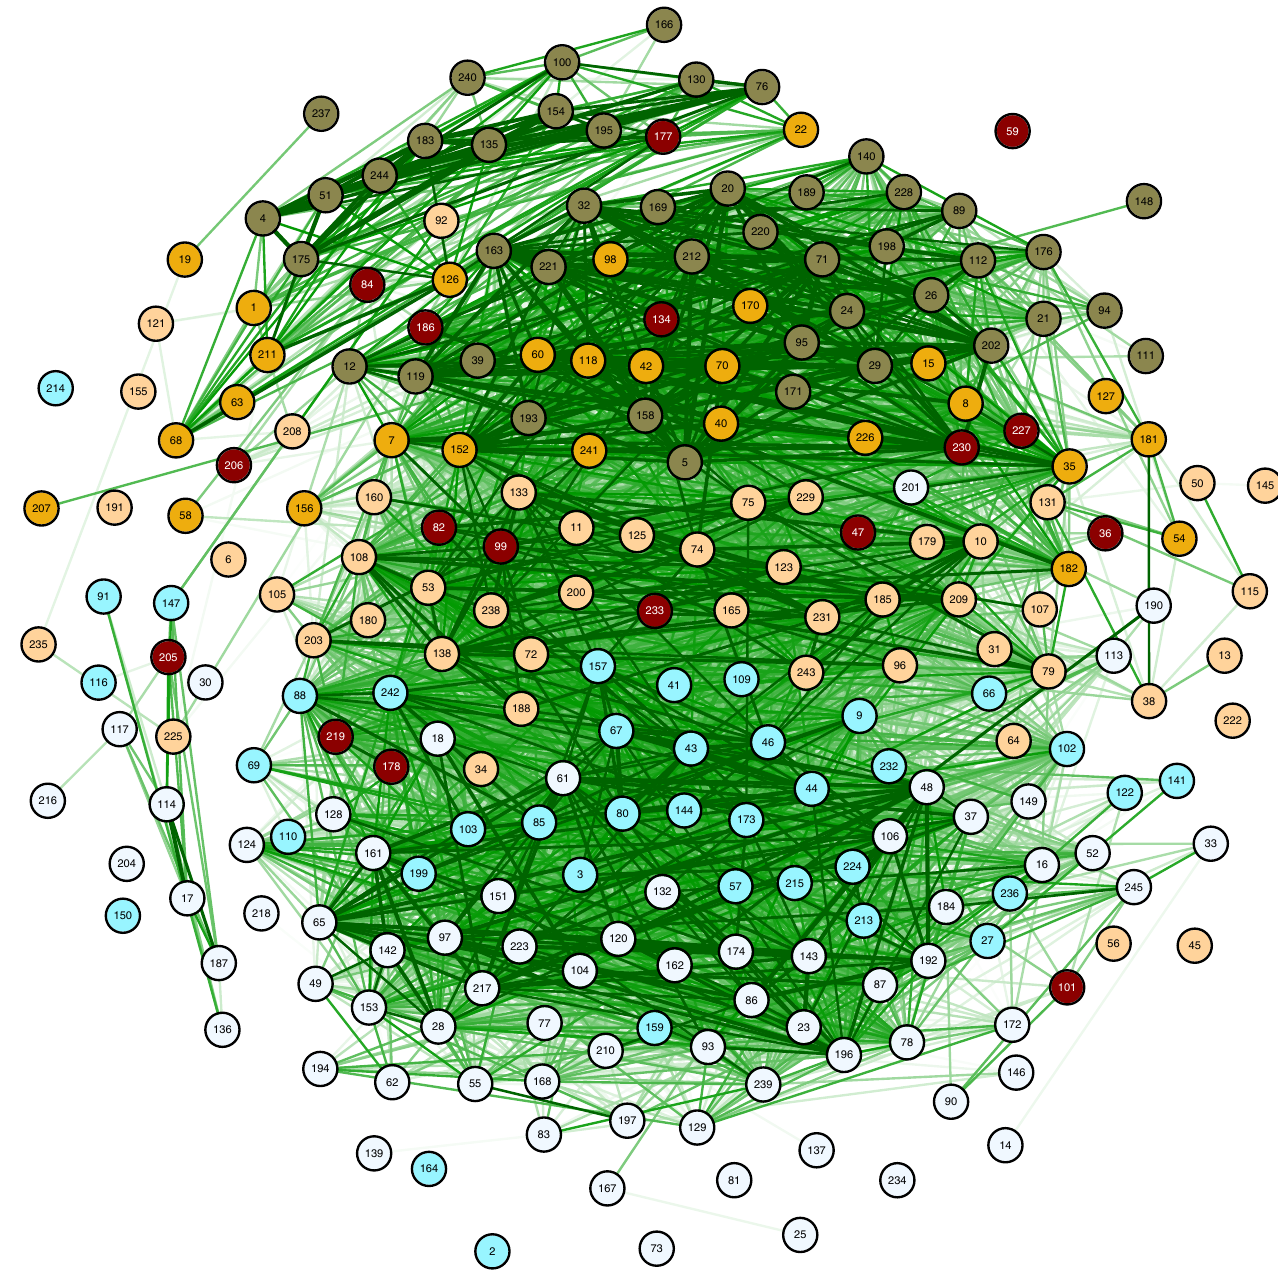
FIG. 3. Force-directed graph of learner similarity based on cosine similarity between the scaled attributes. The light blue color indicates learners who report not visiting the classroom at all, the slightly darker blue learners who report on the average visiting the classroom once per week. The beige colors, with increasing darkness, indicate learners who report on the average visiting the classroom two, three, or four times per week. The dark red indicates learners who had reported more than five sessions per week